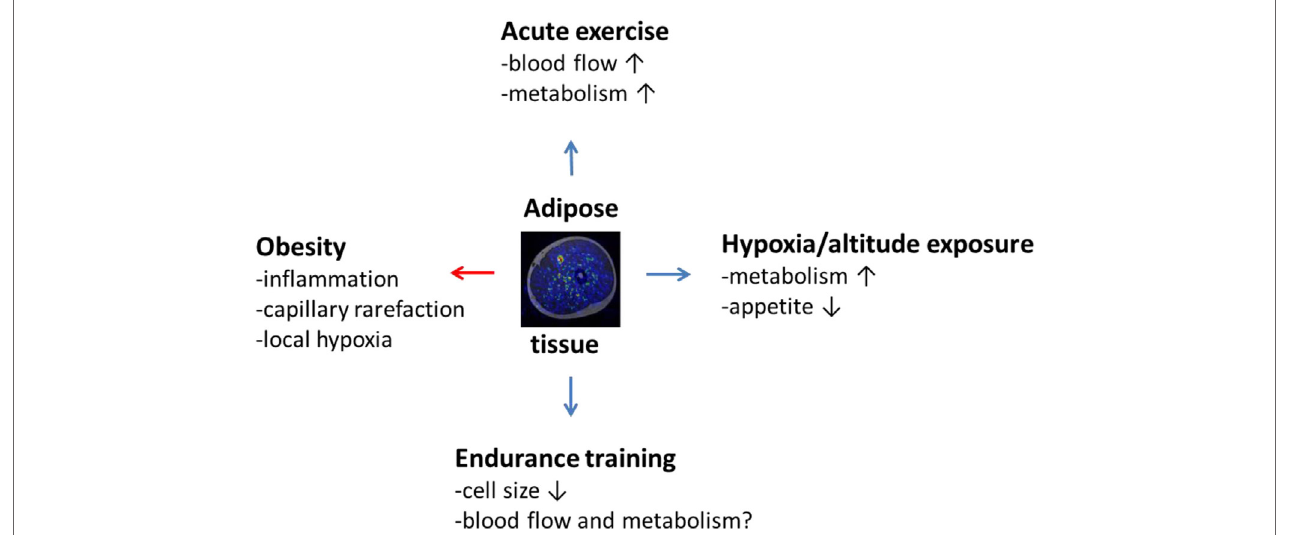
FiGURe 1 | The effects of obesity, acute exercise, hypoxic or altitude exposure, and endurance training on adipose tissue, such as subcutaneous adipose tissue, surrounding thigh musculature as illustrated by the fusion image in the middle of the figure obtained by combining magnetic resonance and positron emission tomography imaging . Obesity induces negative (red arrow) inflammatory state in adipose tissue connected with capillary rarefaction and local hypoxia. Acute low or moderate intensity exercise is on the other hand capable of increasing adipose tissue blood flow and metabolism, which, in the long run, reduces adipose tissue cell size and inflammation. This effect may be potentiated by hypoxic exposure or altitude training, but scientific evidence is still in its infancy to prove this hypothesis correct. It also remains to be investigated to what extent classical endurance training can affect adipose tissue blood flow and metabolism in